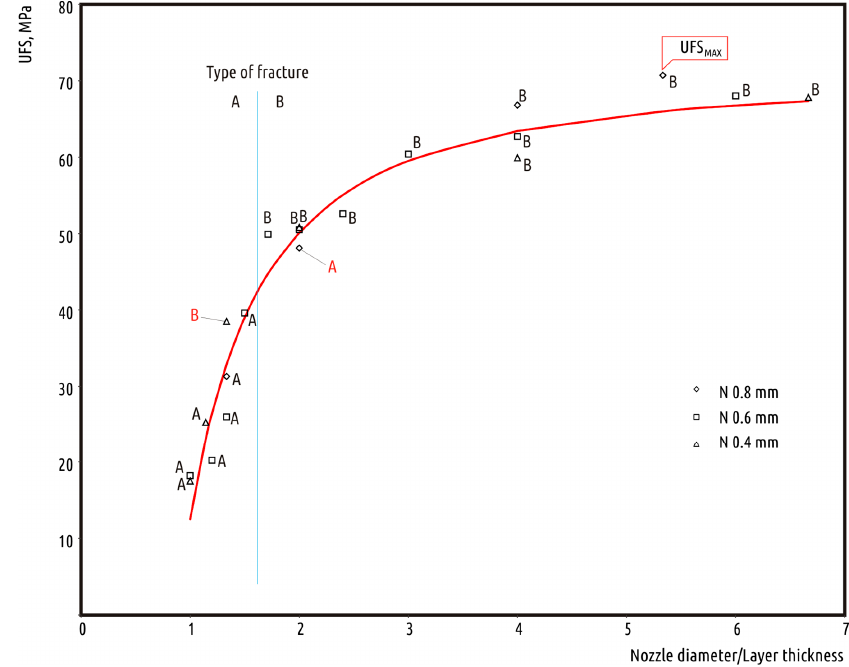
Figure 5. Ultimate flexural strength of the tested samples versus nozzle diameter-to-layer height ratio. The curve fitting the experimental data with adequate accuracy may be represented by formula: UFS = UFS MAX − 58.19/( r 1.5 ),